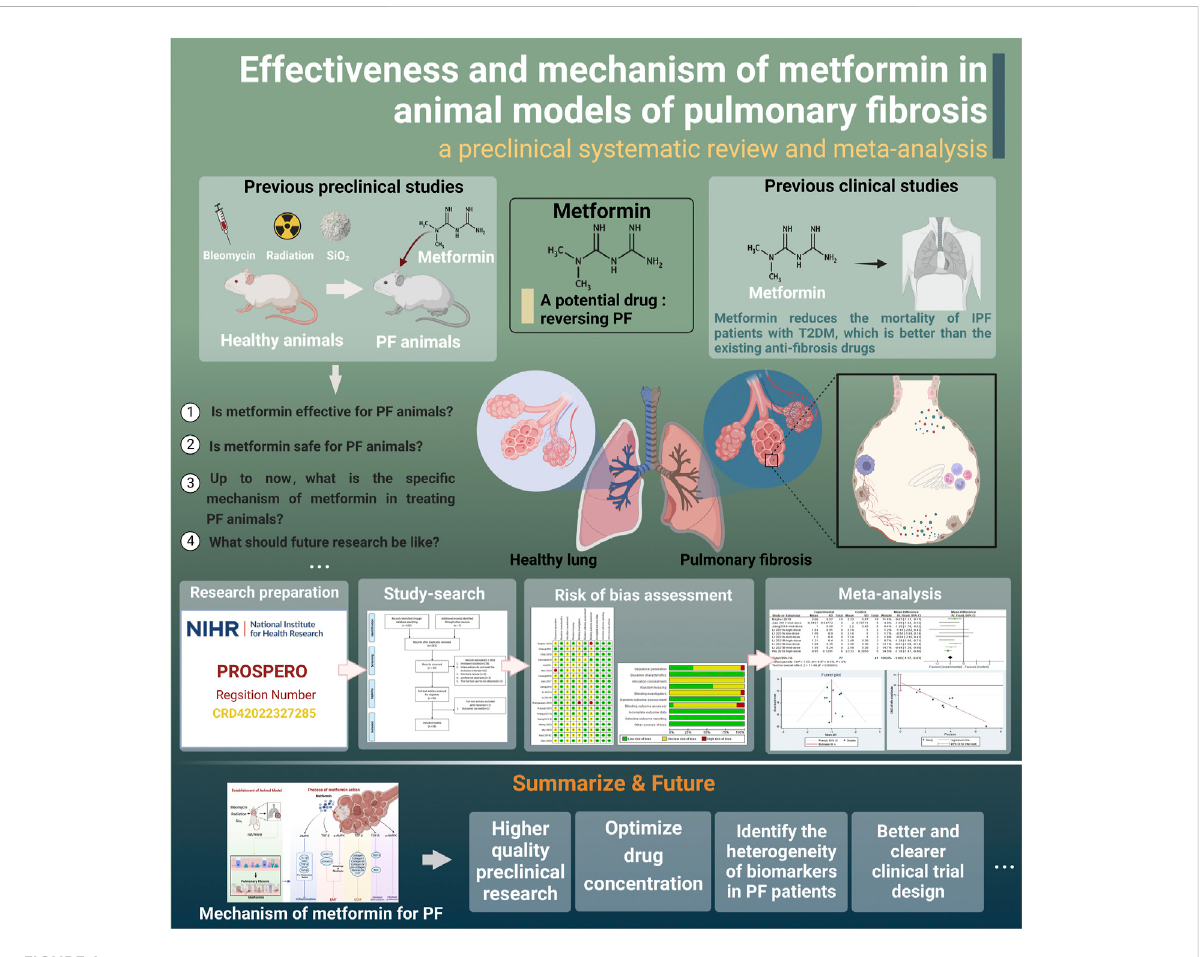
FIGURE 1 Research roadmap (created using